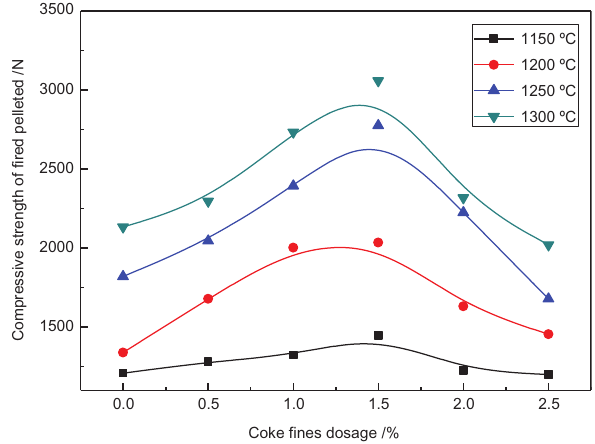
Figure 3: Effect of coke fines dosage on compressive strength at different firing temperature (Preheating at 1,050°C for 15 min and firing for 15 min).